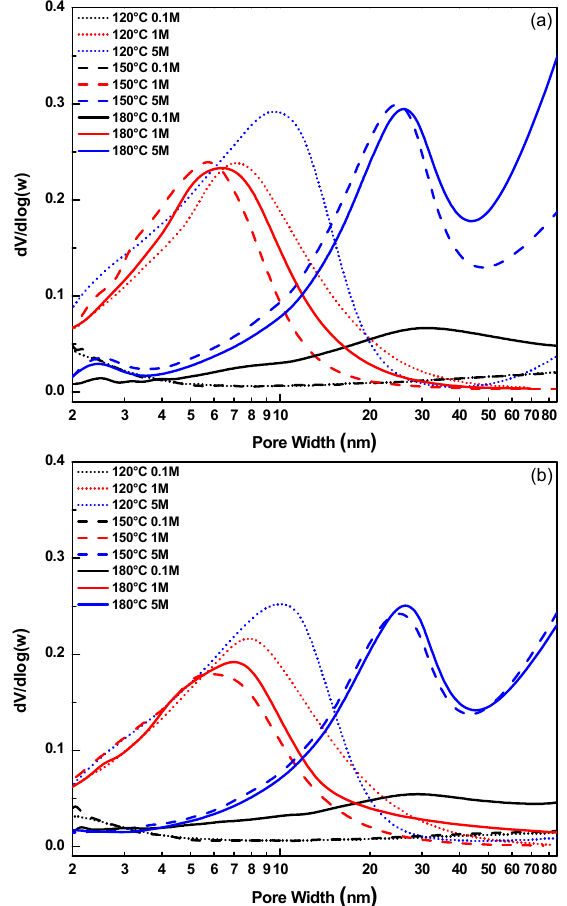
Figure 2. Pore size distribution of pure ceria supports ( a ) and CuCe oxide catalysts (b).